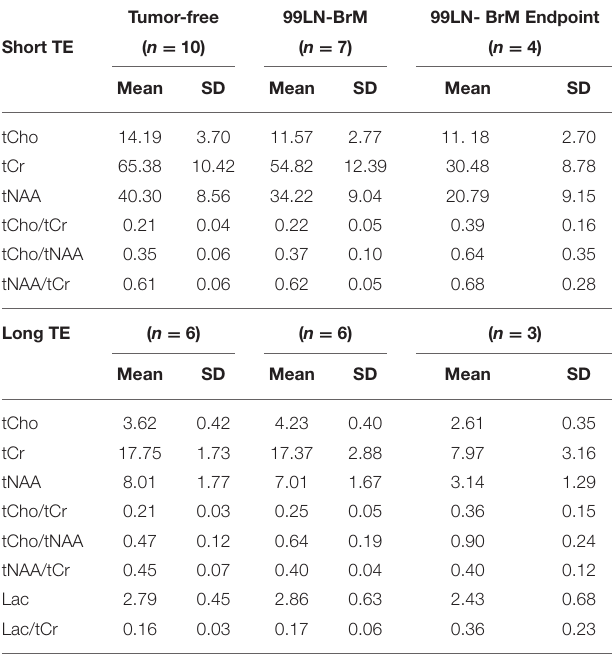
TABLE 1 | Metabolite and metabolite ratios (mean with s.d.) of tumor-free, 99LN-BrM and 99LN-BrM Endpoint mice for short echo time (16.5ms) and long echo time (135ms)